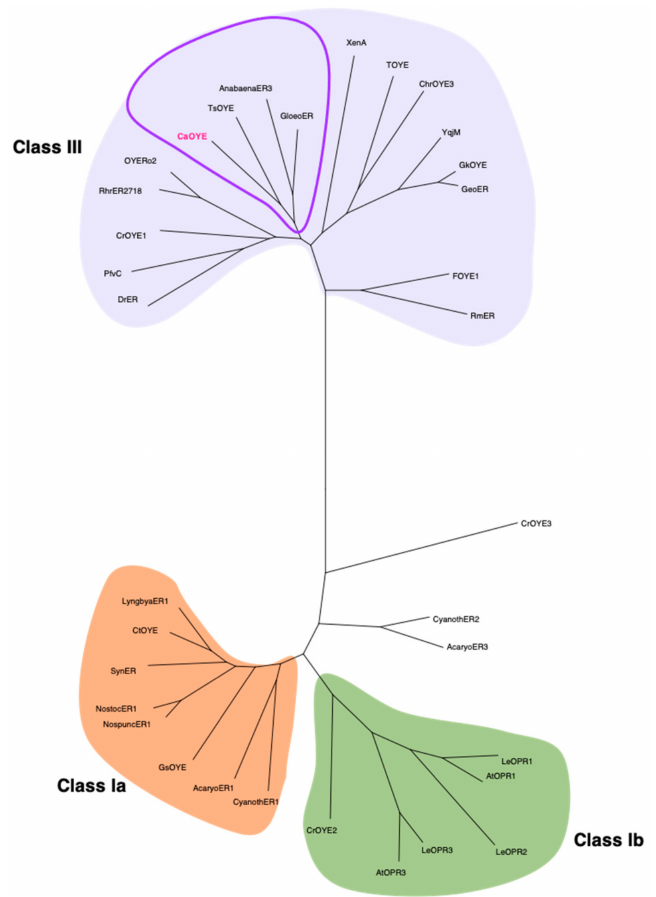
Figure 1. Phylogenetic analysis of Ca OYE and previously described OYEs from photosynthetic organisms and Class III OYEs. The evolutionary history conducted in MEGA X was inferred by using the Maximum Likelihood method. The corresponding alignment was produced via ClustalW alignment: AcaryoER1 and AcaryoER3 from A. marina MBIC11017, AnabaenaER3 from T. variabilis ATCC 29413, At OPR1 and At OPR3 from A. thaliana , Ca OYE from C. aggregans , Chr -OYE3 from Chryseobacterium sp. CA49, Cr OYE1, Cr OYE2 and Cr OYE3 from C. reinhardtii , Ct OYE from C. thermalis , CyanothER1 and CyanothER2 from R. orientalis PCC 8801, Dr ER from D. radiodurans R1, FOYE-1 from Ferrovum sp. JA12, Geo ER from Geobacillus sp. #30, Gk OYE from G. kaustophilus HTA426, GloeoER from G. violaceus PCC 7421, Gs OYE from G. sulphuraria , Le OPR1, Le OPR2 and Le OPR3 from S. lycopersicum , LyngbiaER1 from Lyngbya sp. PCC 8106, NospuncER1 from N. punctiforme PCC 73102, NostocER1 from Nostoc sp. PCC 7120, OYERo2 from R. opacus 1CP, PfvC from Arthrobacter sp. JBH1, Rhr ER2718 from R. rhodochrous ATCC 1795, Rm ER from C. metallidurans CH34, SynER from S. elongatus PCC 7942, TOYE from T. pseudethanolicus ATCC, Ts OYE from T. scotoductus SA-01, XenA from P. putida , YqjM from B. subtilis